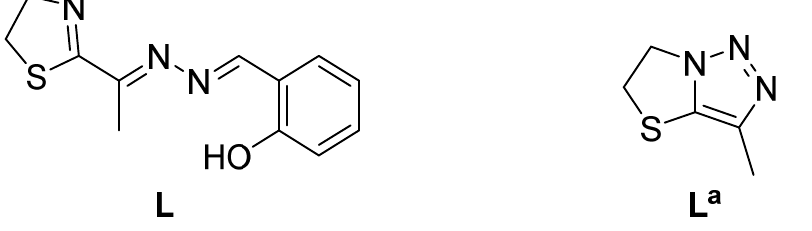
Figure 1. Structure of the presented ligands 1-(((4,5-dihydrothiazol-2-yl)ethylidene) hydrazone)methyl)phenol, L , and 3-methyl-5,6-dihydrothiazolo[3,2-c][1,2,3]triazole, L a .